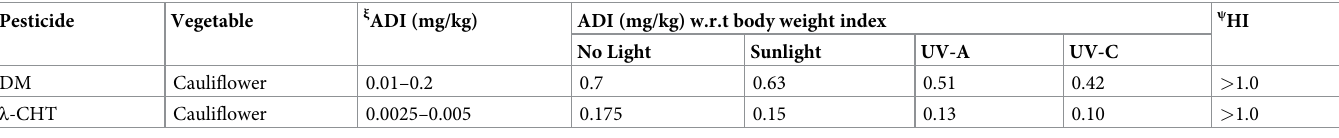
Table 6. Risk assessment of pesticides residues in cauliflower. Pesticide